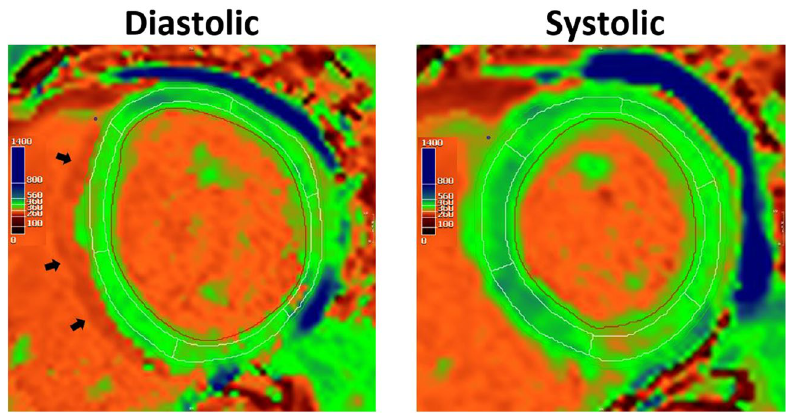
Figure 4. Diastolic and systolic T1 maps, analysed with 20% offset of endocardial and epicardial contours, split into six American Heart Association segments. Suspicions for diastolic mapping gating artefact is raised by the presence of a subtle “double” septal border (black arrows), which can be visualised when comparing the individual acquisition images (Video 1). R 2 in systole was higher in 62% of cases, whilst diastolic measurement was higher in 32% (6%